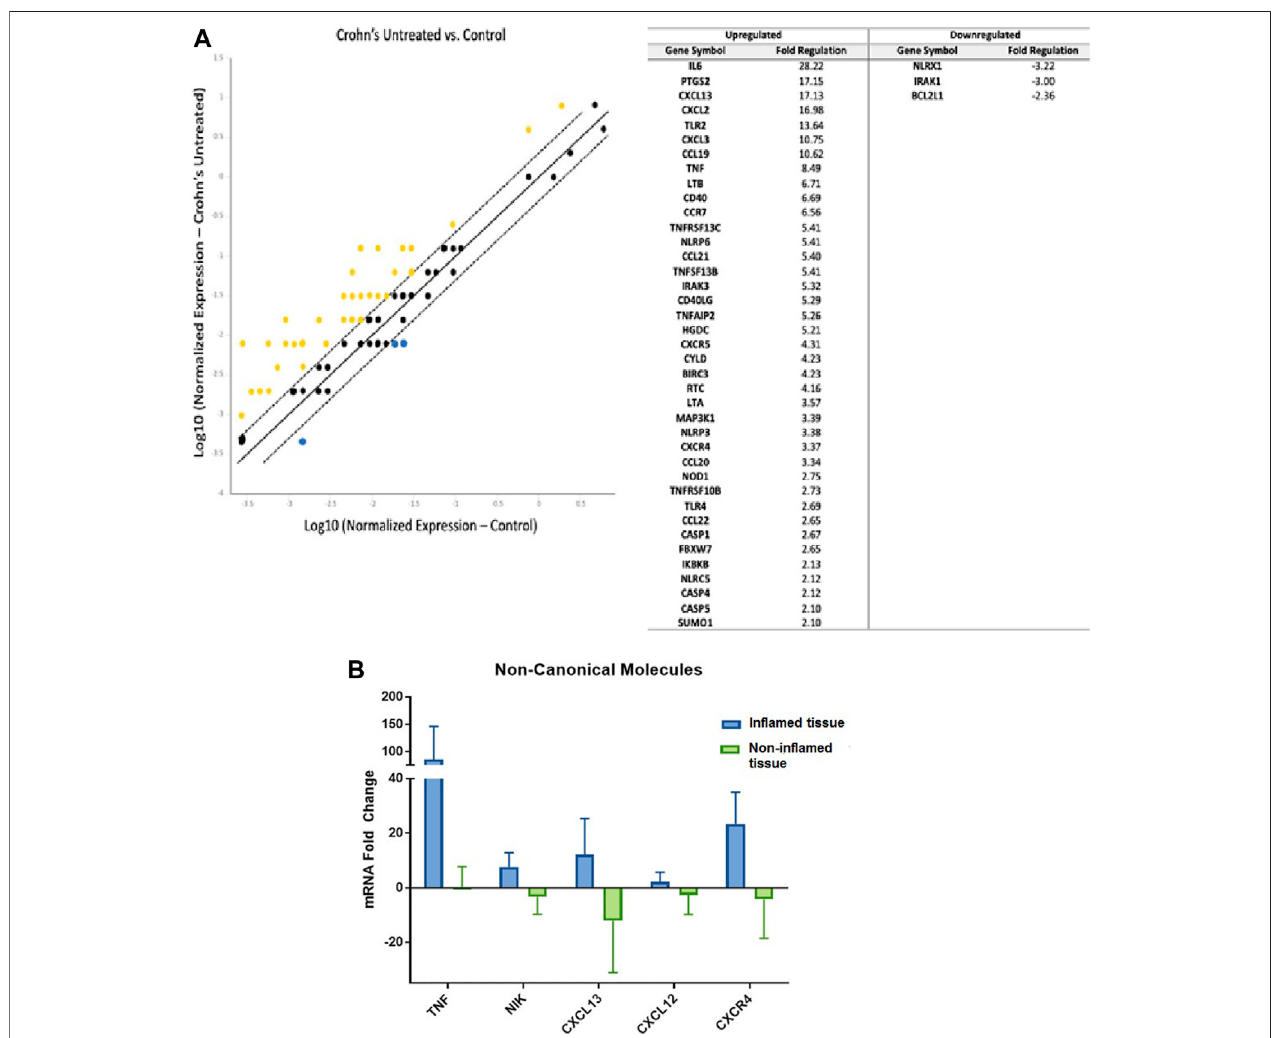
FIGURE1| NoncanonicalNF- κ BSignalingisUpregulated inIn fl ammatoryBowelDiseasePatients (A) Left:Compared togeneexpressionfromintestinaltissuesof controls( n (cid:2) 15,3pools),39genesrelatedtononcanonicalNF- κ BpathwaywereupregulatedinintestinaltissuesobtainedfromuntreatedCDpatients( n (cid:2) 2,1pool)with yellow indicating upregulation and blue indicating downregulation (lines represent 1, 0, and − 1 fold change; genes outside of dashed lines are considered signi fi cantly dysregulated). Housekeeping genes used for normalization include ACTB, B2M, and GADPH; Right: list of 39 upregulated genes and three downregulated genes and fold change values. (B) . Using real-time PCR of individual patient samples, the main noncanonical NF-kB pathway components TNF, NIK, CXCL12, CXCL13, and CXCR4werefoundtobeupregulatedinin fl amedareascomparedtonon-in fl amedareasobtainedfromthesameindividualpatients(in fl amedlesions n (cid:2) 4;non-in fl amed tissue n (cid:2)